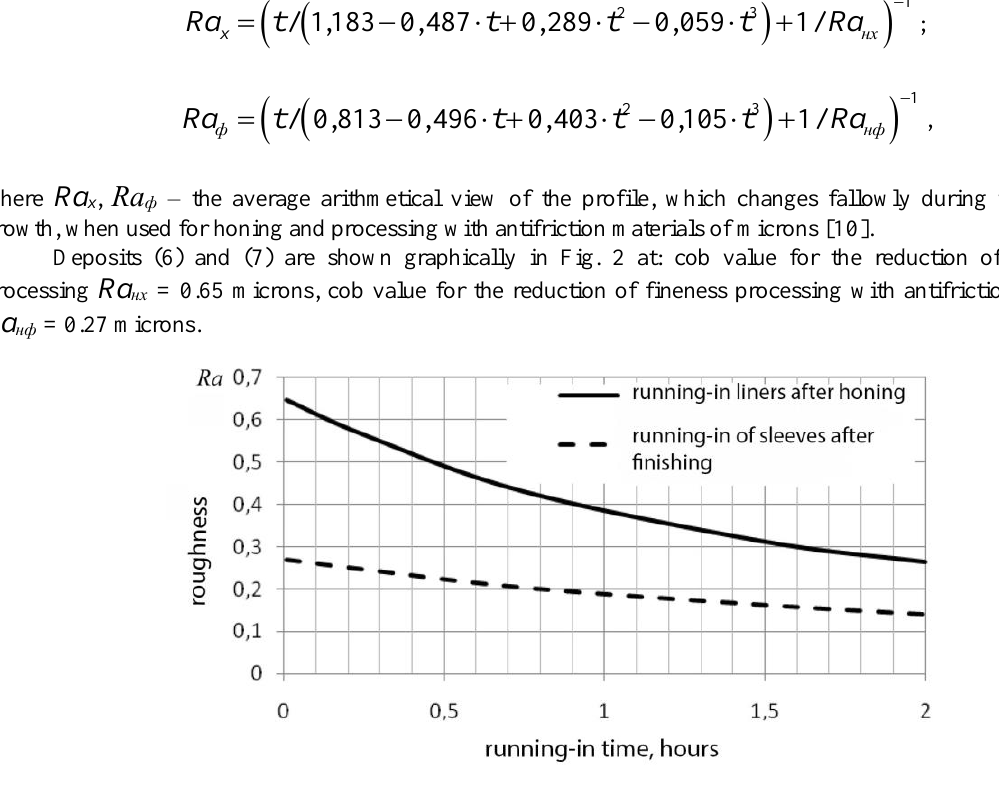
Fig. 2. The prevalence of the mean arithmetic output to the profile at the hour of